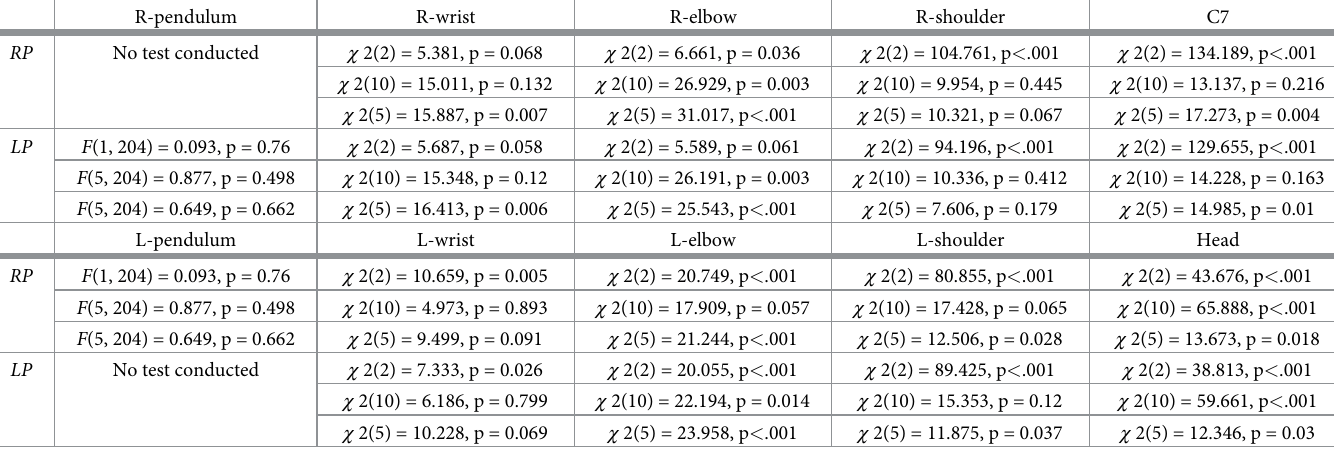
Table 3. Results of the two-way Harrison-Kanji test for phase differences (in-phase condition). R-pendulum R-wrist R-elbow R-shoulder